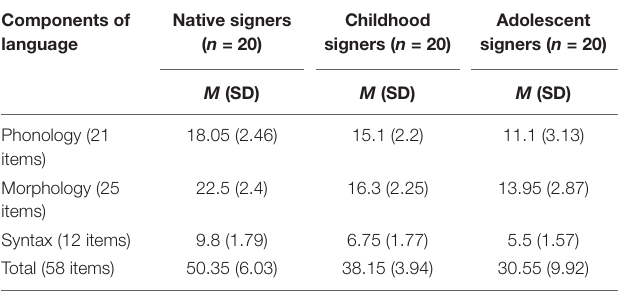
TABLE 2 | Mean accuracy (SD) for each group of participants on each subsection of the PJM-PCT. Components of